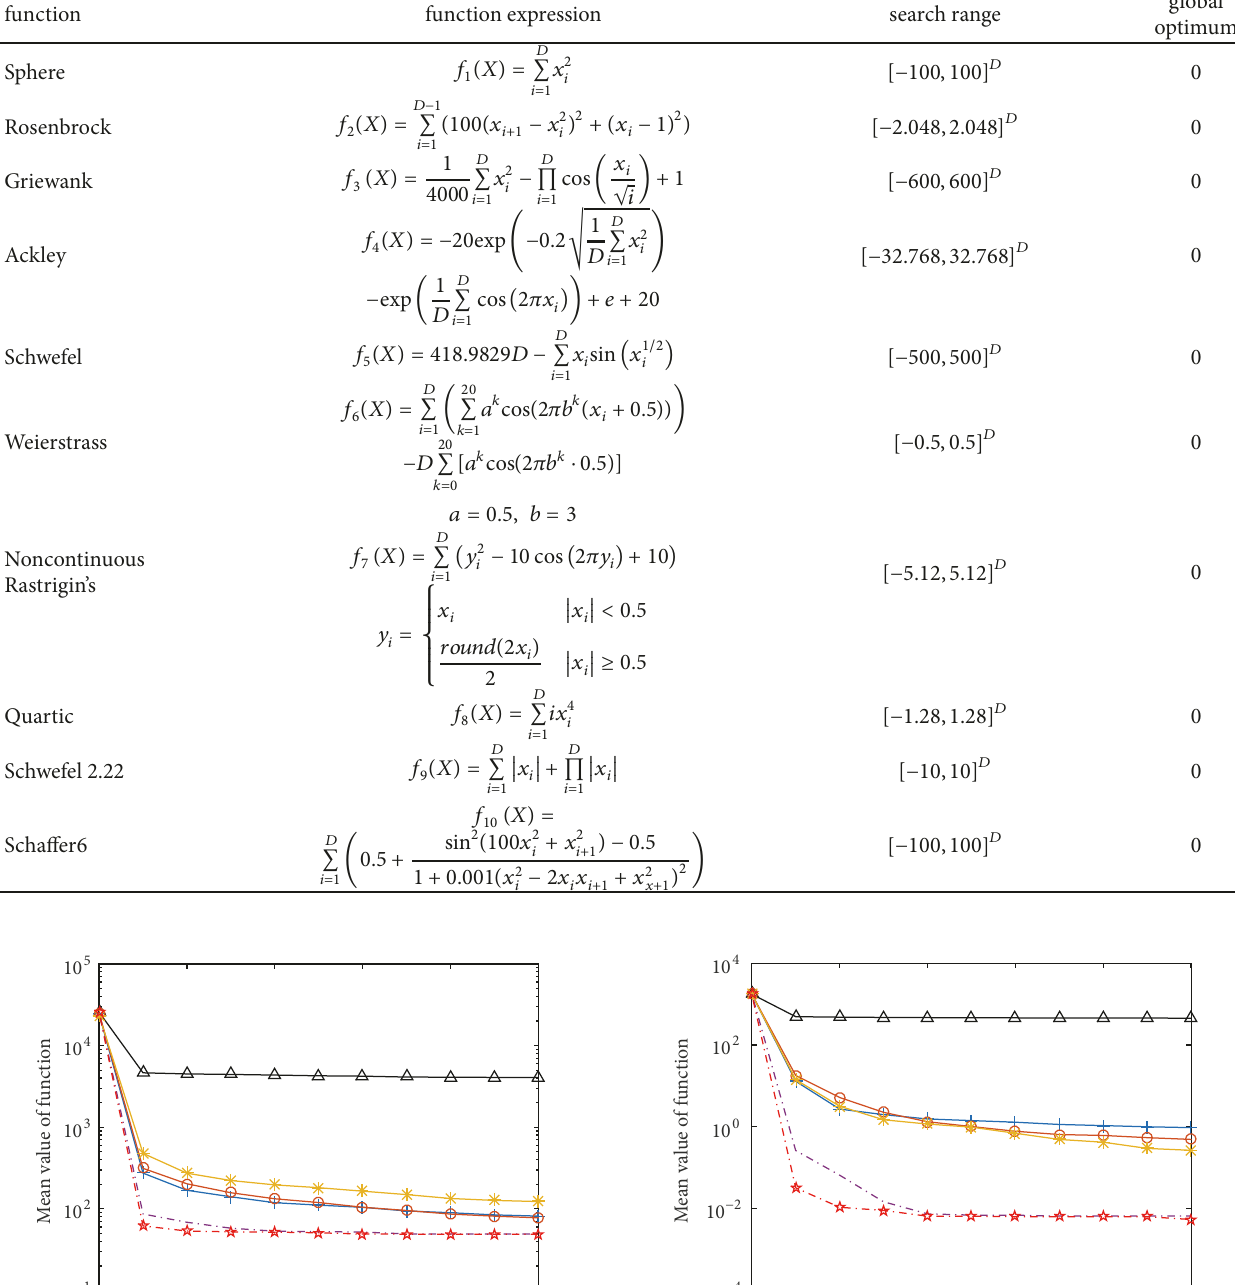
Table 1: Benchmark functions.